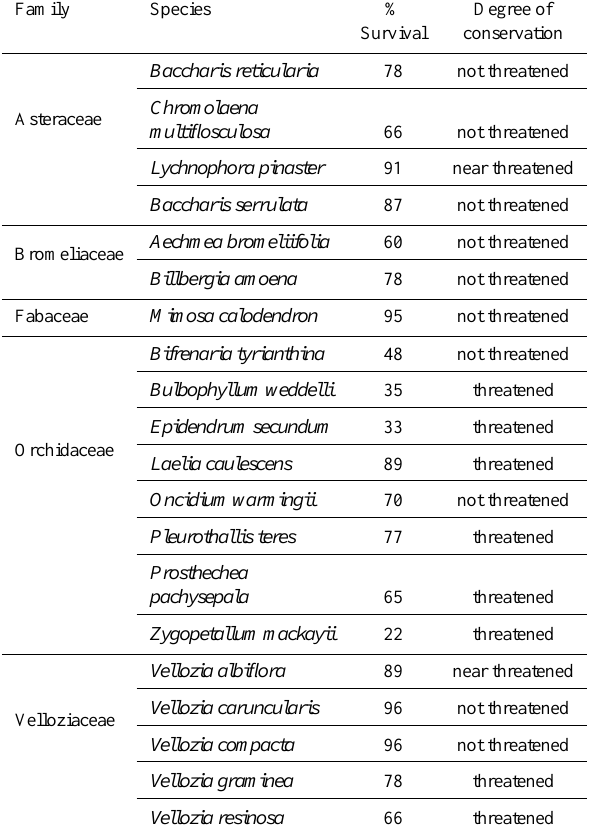
Table 1. Main species planted in Serra do Rola Moça State Park with absolute percentage of survival amount and degree of conser- vation (system of categories and criteria of IUCN – Red Book of Flora of Brazil – Rare Plants Cerrado, Martinelli et al., 2014).